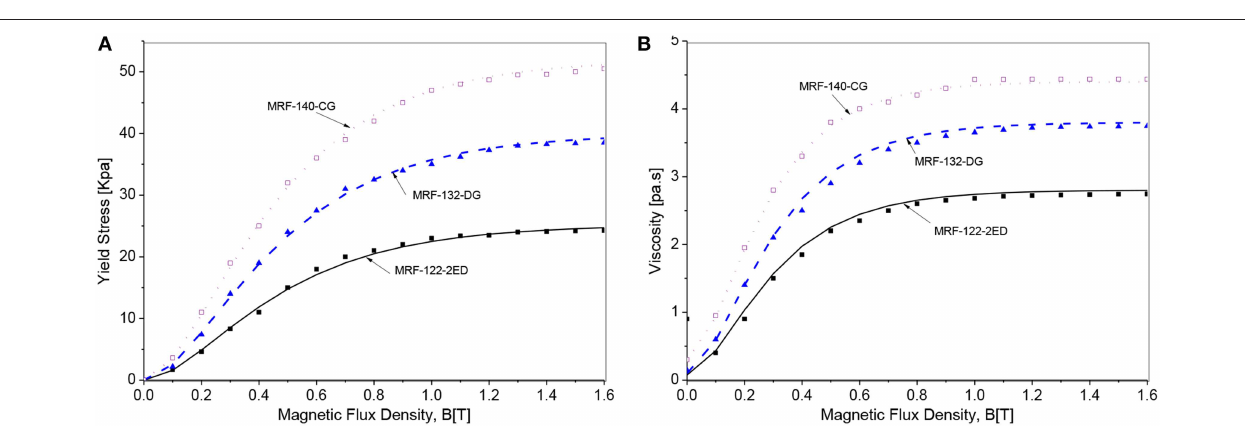
FIGURE 5 | Rheological properties of MR fluids. (A) Field dependent yield stress. (B) Field dependent post-yield viscosity.